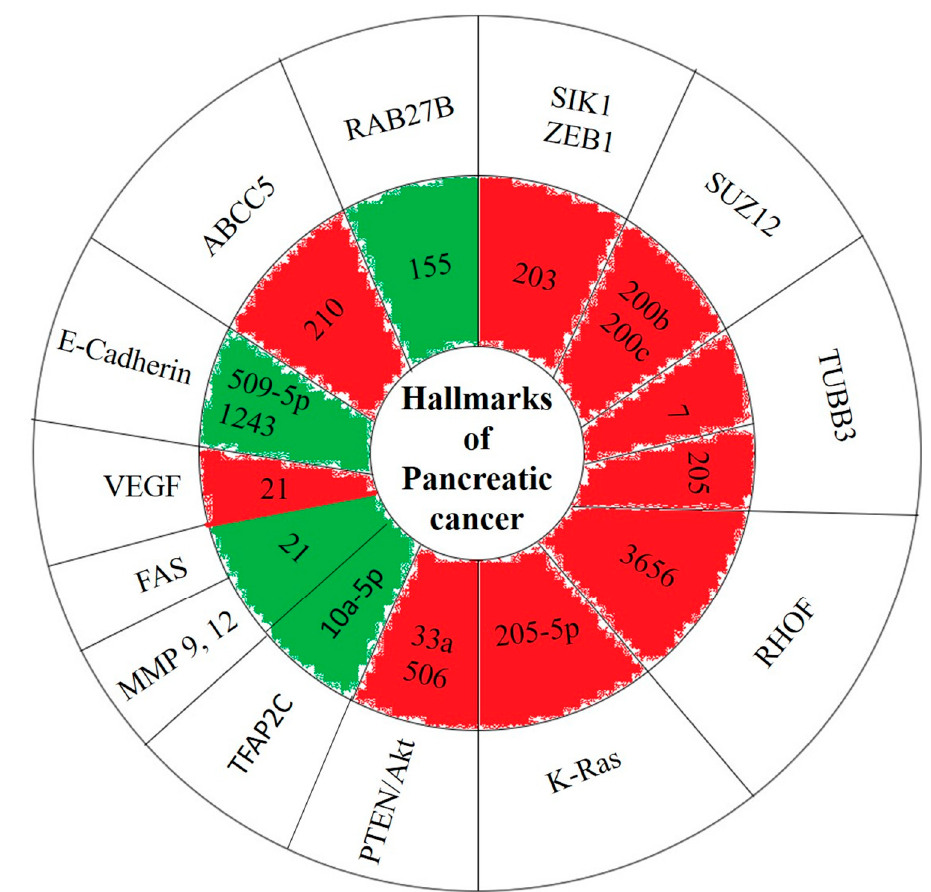
Figure 3. Hallmarks of PC. The shells highlighted in red are miRNAs that are downregulated while green denotes upregulated in pancreatic cancers in comparison to normal tissue.